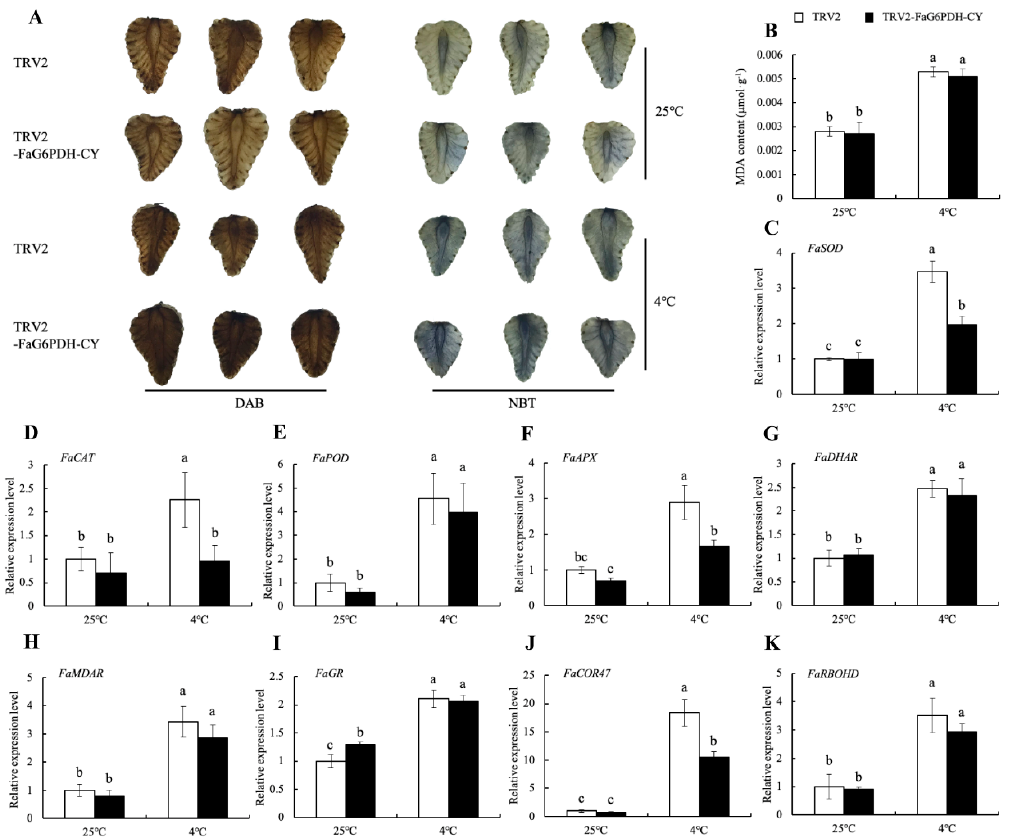
Figure 7. Effect of FaG6PDH-CY silencing on strawberry fruits in response to cold stress. silencing strawberries were sampled after 6-day treatment at 4 ◦ C and 25 ◦ C to detect ROS production ( A ), MDA content ( B ) and gene expression ( C–K ). H 2 O 2 was indicated by the presence of deep brown using 3, 3-diaminobenzidine (DAB) staining. O 2 − was indicated by the presence of dark blue using